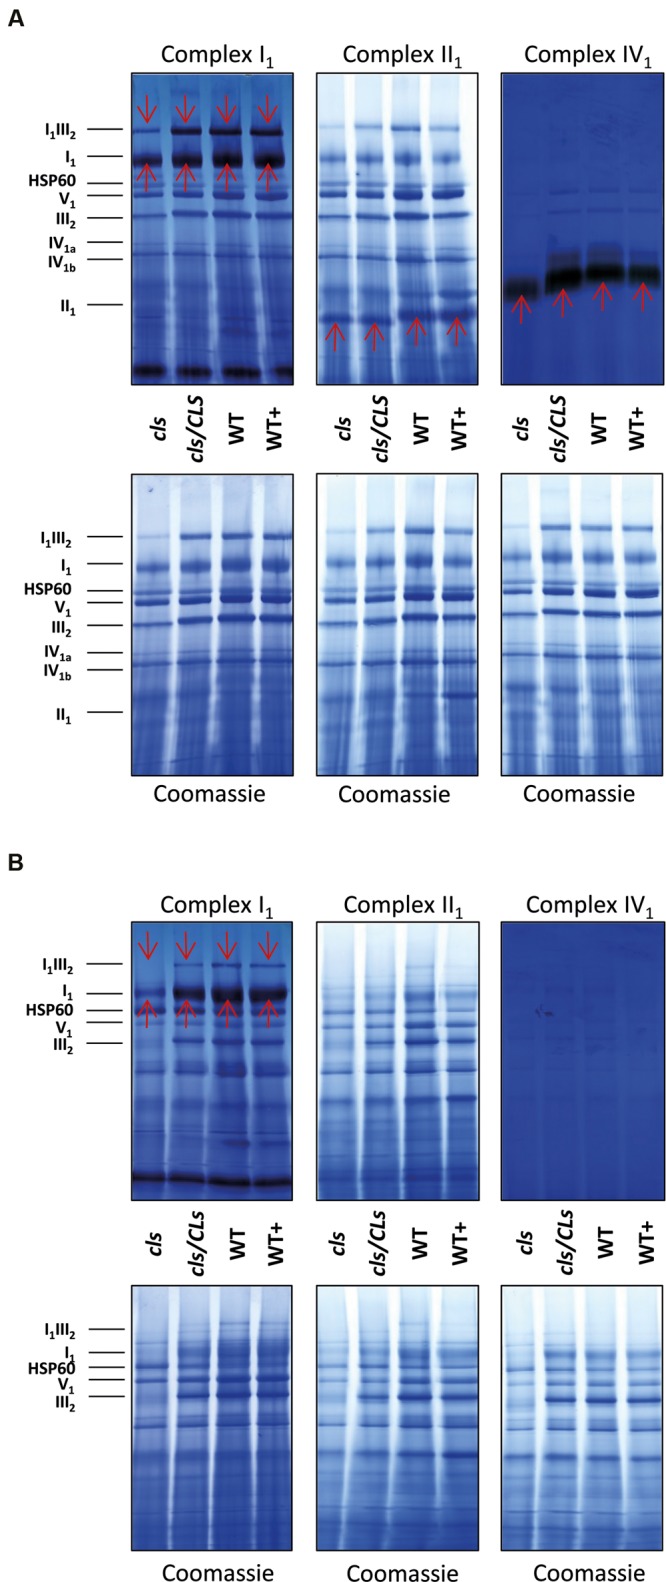
1D BN gels of mitochondria used for in gel activity assays for complexes I, II, and IV and stained with Coomassie afterward (upper panels) and control Coomassie stained gels (lower panels).
(A) Digitonin solubilized mitochondria; (B) DDM-solubilized mitochondria. Identities of protein complexes/supercomplexes are given on the right. Red arrows indicate activity stained bands.